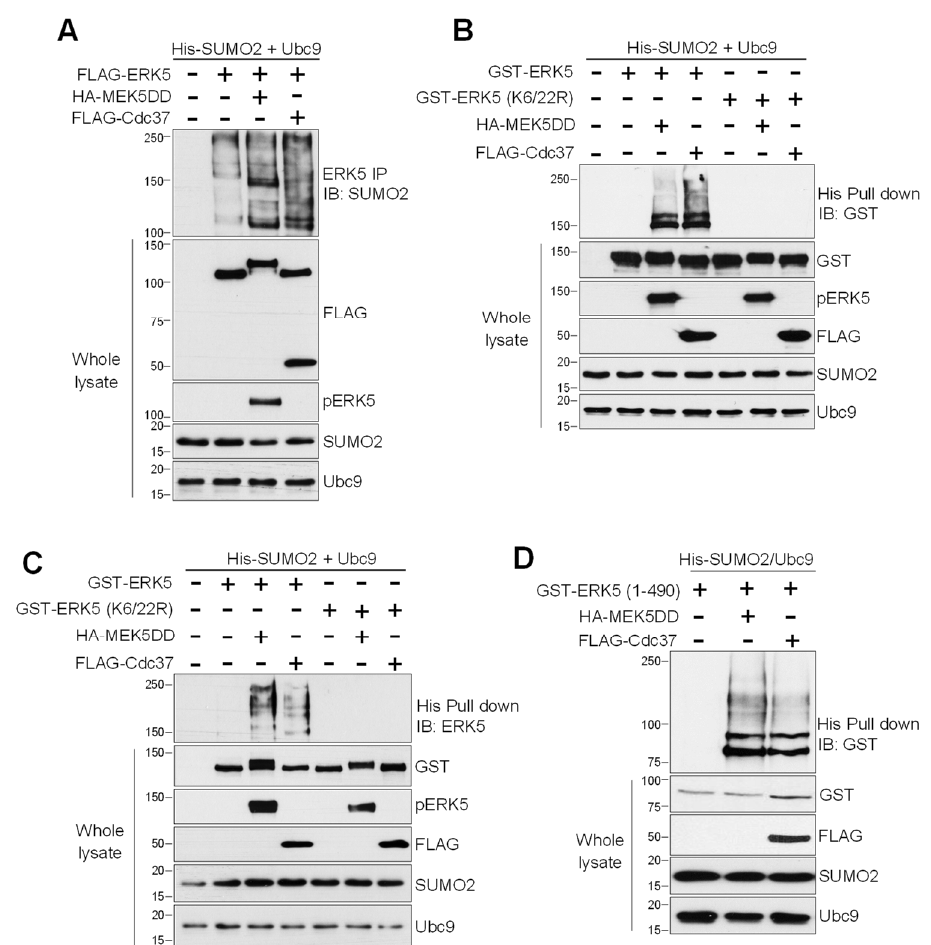
Figure 1. MEK5 phosphorylation or Cdc37 overexpression induce ERK5 Small Ubiquitin-related Modifier (SUMO)ylation. HEK293T cells we co-transfected with His-tagged SUMO2 and Ubc9 and the indicated combinations of FLAG-tagged ERK5 ( A ) or GST-tagged ERK5 (wild type or SUMO-deficient K6/22R mutant) ( B,C ). Cells were also transfected with MEK5DD (constitutively active) or Cdc37 to induce ERK5 nuclear translocation. After lysing cells with RIPA buffer containing NEM, ERK5 was immunoprecipitated, and SUMOylated species were detected by immunoblotting with anti-SUMO2 antibody ( A ). In parallel experiments, cells were lysed with denaturing buffer containing NEM, and SUMOylated ERK5 was affinity-purified using Ni 2+ -agarose beads and detected by immunoblotting with anti-GST ( B ) or anti-ERK5 ( C ) antibody. Levels of overexpressed proteins and phosphorylated ERK5 at the T-loop are shown using the corresponding antibodies. (D) SUMOylation analysis of ERK5 N-terminal half. Experiments were performed as in B , using a mutant form of ERK5 that encodes for the aa 1–490 which contains the kinase domain (aa 54–346). Similar results were obtained in three separate experiments.